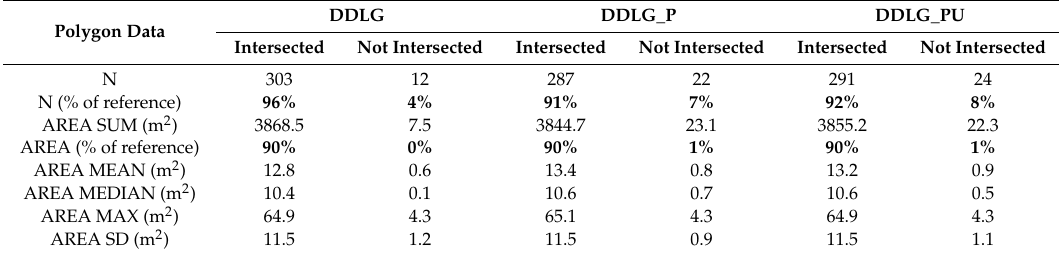
Table 9. Results of the polygon-based validation. Basic statistics (N, % of N reference polygons, (in bold), area sum, percent of the reference area (in bold), area mean, median, maximum, and standard deviation) for the deadwood patches identified by the three classification scenarios: Random forest (RF) classification (DDLG), RF classification with post-processing (DDLG_P), and with a deadwood-uncertainty filter (DDLG_U), that were validated (intersected) and not validated (not intersected) when compared with the reference deadwood